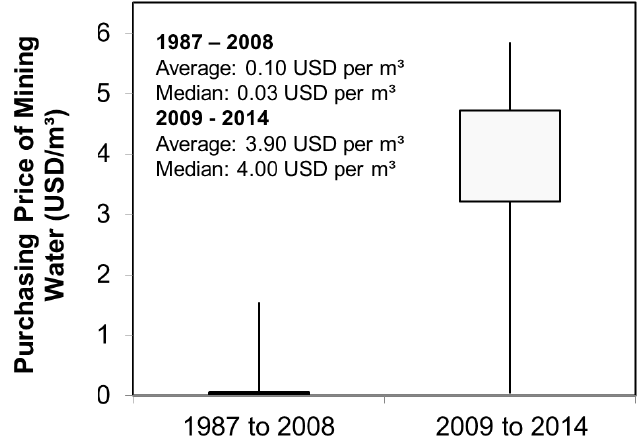
Figure 10. In the areas that encompass the Eagle Ford Shale and the Permian Basin, water prices in the mining sector increased dramatically since 2009. The box plots show the 1st and 3rd quartiles within the boxes and the data beyond those quartiles as whiskers. (Data were acquired from various sources including private operators and [12,23,49–67]. The dataset includes approximately 30 transactions prior to 2009 and over 1200 transactions after 2009).